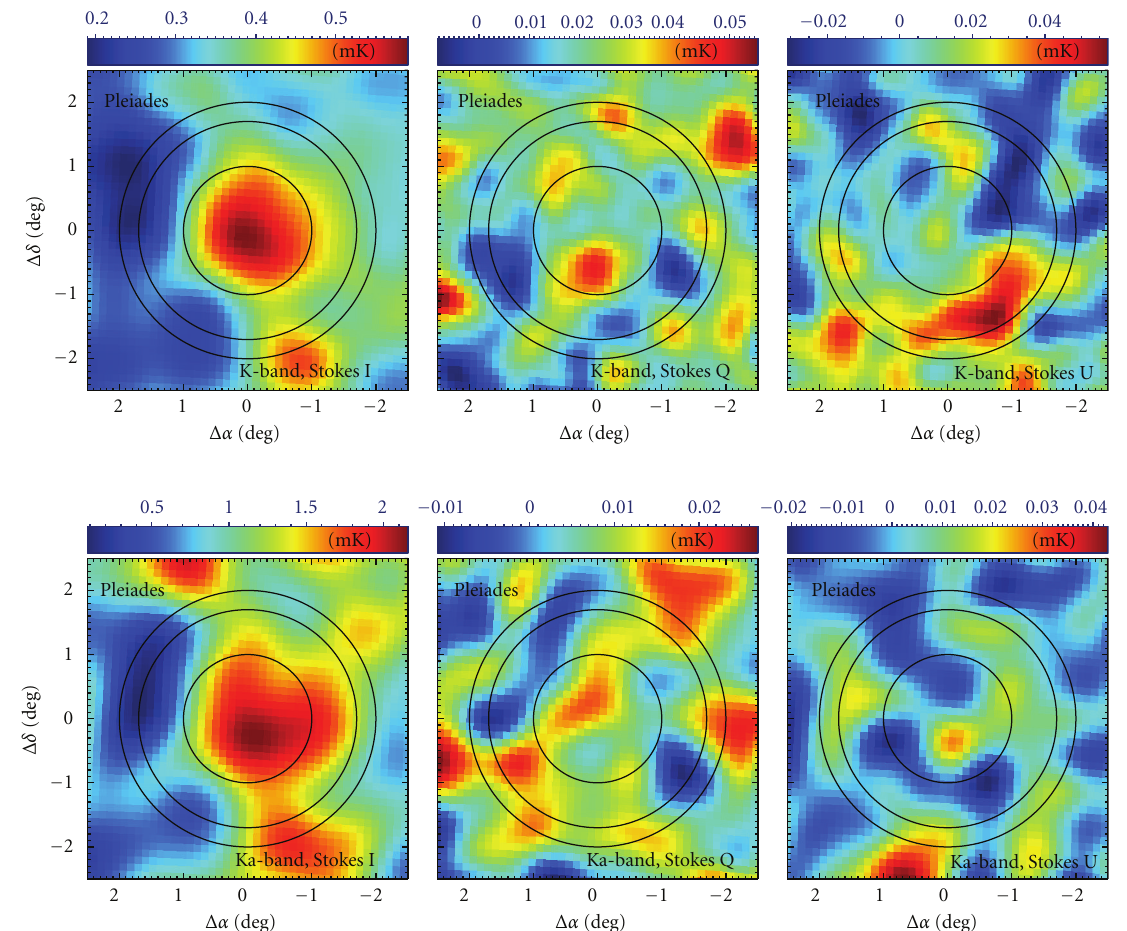
Figure 5: The same as Figure 3, but for the Pleiades region. The apertures now correspond to the radii r 0 = 1 ◦ , r 1 = 1 . 5 ◦ , and r 2 = 2 ◦ . = 0 ◦ .79), v3 : (R.A. = 87 ◦ .79; Dec. : − 1 ◦ .53), and v4 : (R.A. = 89 ◦ .91; Dec. = 0 ◦ .03).), we get the intensity fluxes